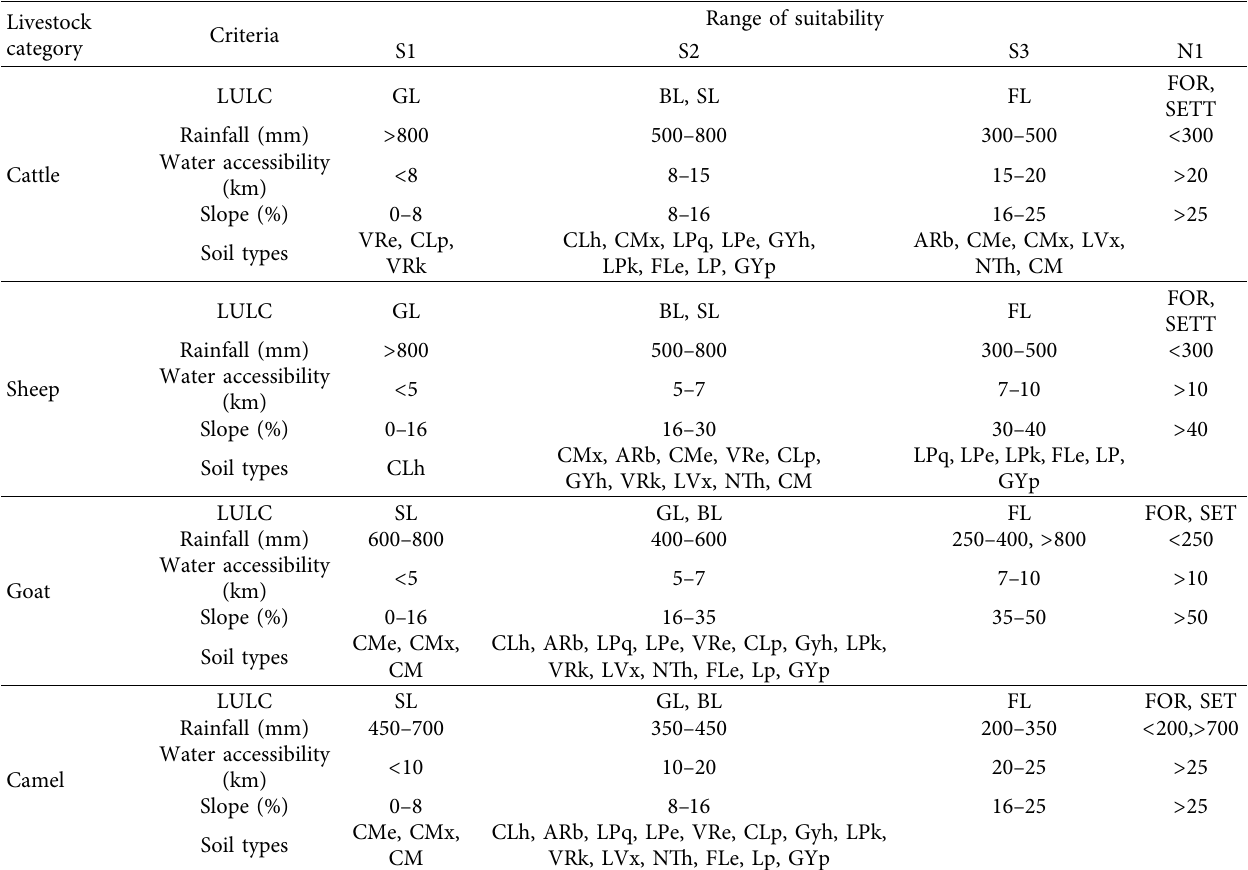
Table 1: Rangeland evaluation criteria and their suitability classes for cattle, sheep, goat, and